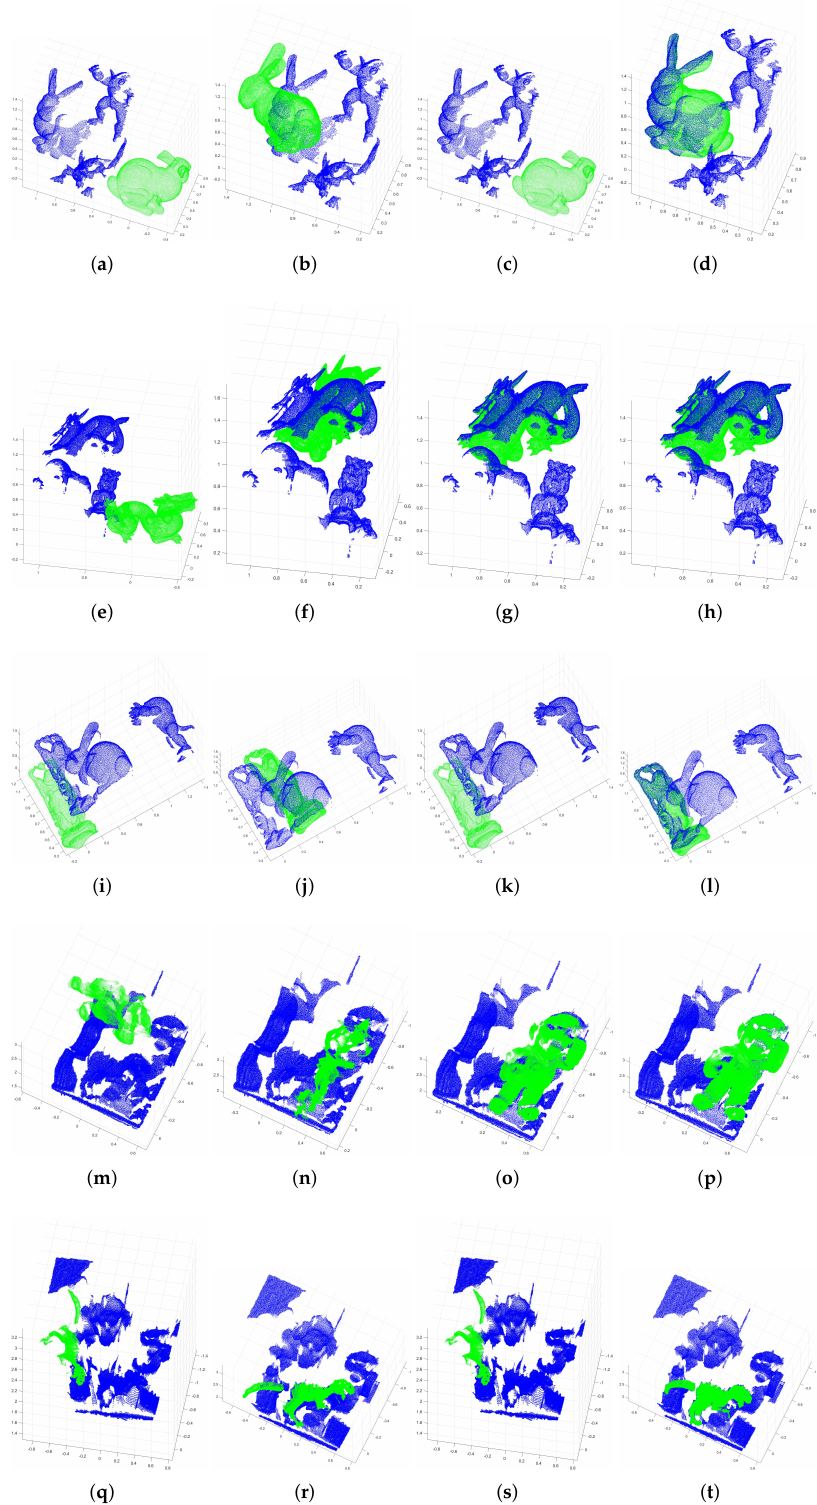
Figure 14. Surface matching results of three methods tested on the selected datasets. The models (in green) and the scenes (in blue) to be matched ( a , e , i , m , q ). NN results ( b , f , j , n , r ), NNDR results ( c , g , k , o , s ), and our method results ( d , h , l , p , t